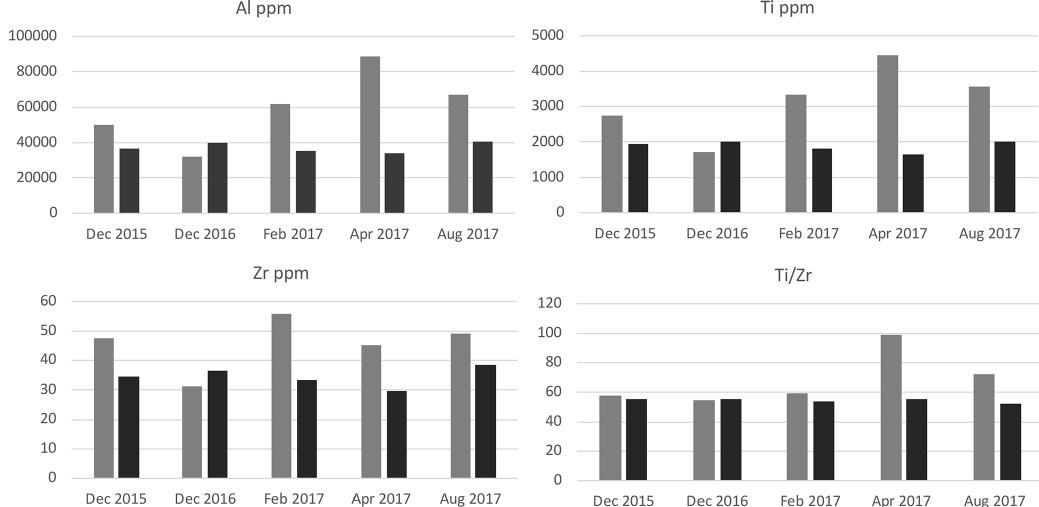
Figure 5. Al, Ti, and Zr concentration values in parts per million (ppm) and the Ti / Zr ratio of surface samples collected at Callao stations. Gray: E2 stations (92m depth), black: E5 station (178m depth).